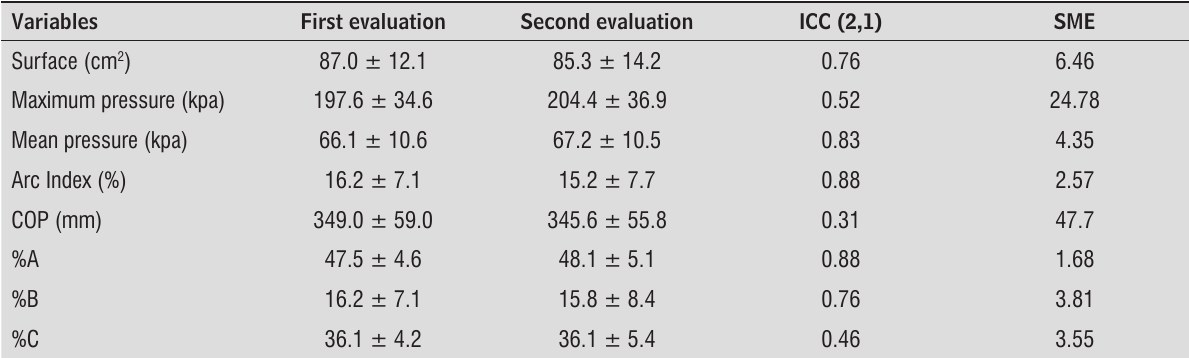
Table 1 - Descriptive analysis of baropodometric variables, relative and absolute reliability during semi-static evaluation (n = 66) Variables First evaluation